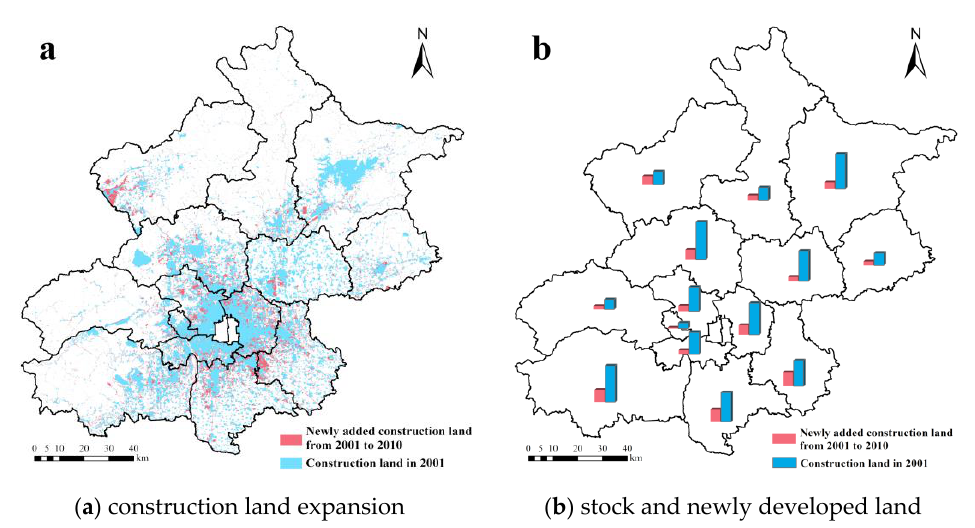
Figure 3. Distribution of construction land expansion in Beijing from 2001 to 2010.